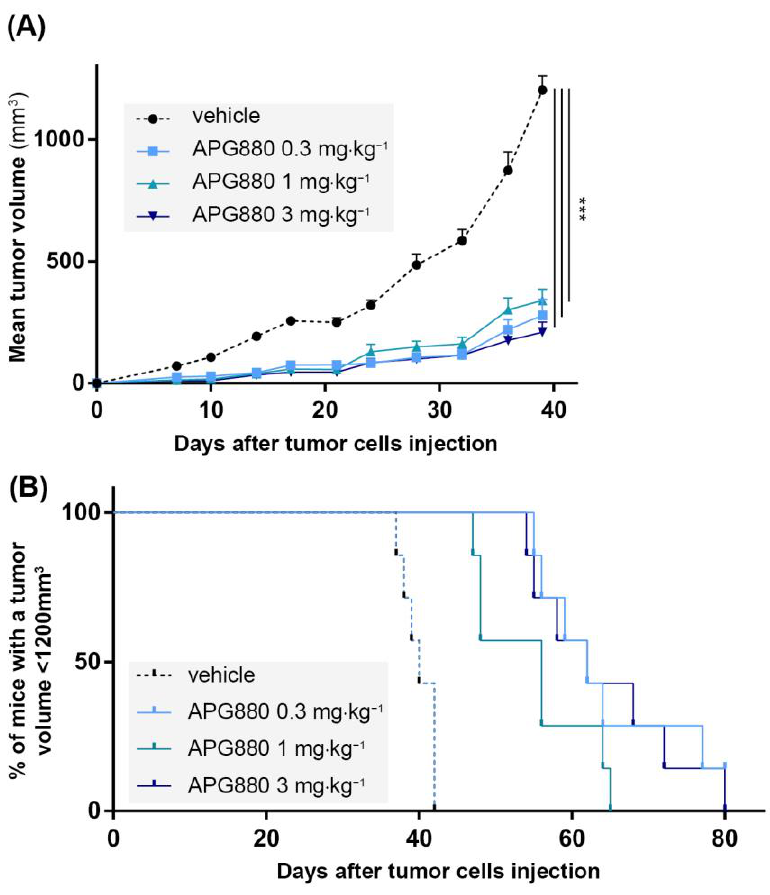
Figure 6. In vivo, APG880 decreases K-HOS cell-induced tumor progression. Four groups of seven mice received intramuscular paratibial injection of 1.10 6 K-HOS cells. Each group was injected twice a week with 0; 0.3; 1 or 3 mg ⋅ kg −1 of APG880. ( A ) Mean tumor volume per group calculated twice a week. ( B ) Survival evaluated by the percentage of mice with a tumor volume less than 1200 mm 3 . (*** p < 0.001).